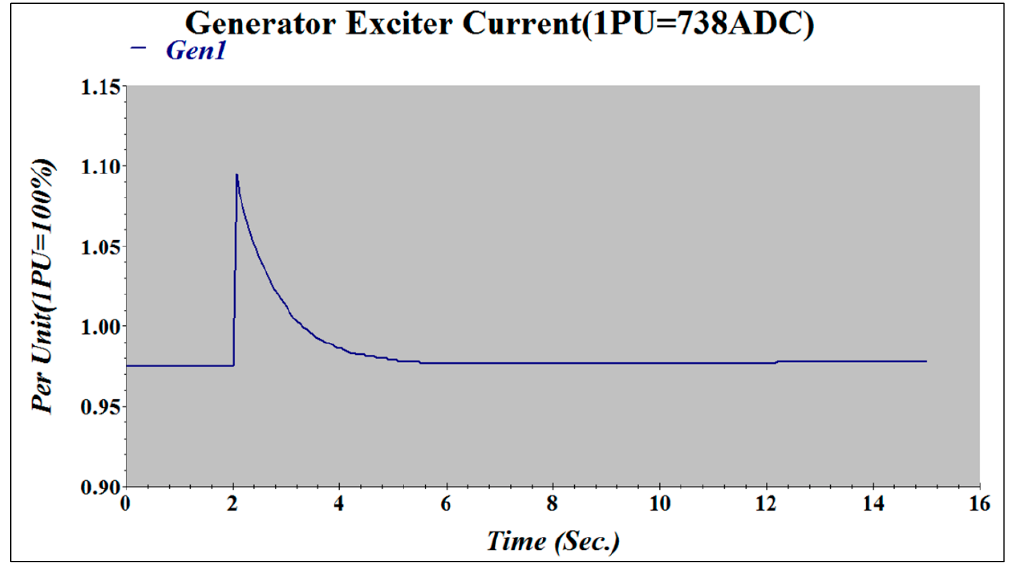
Figure 10. With OEL at − 10% impact in grind.